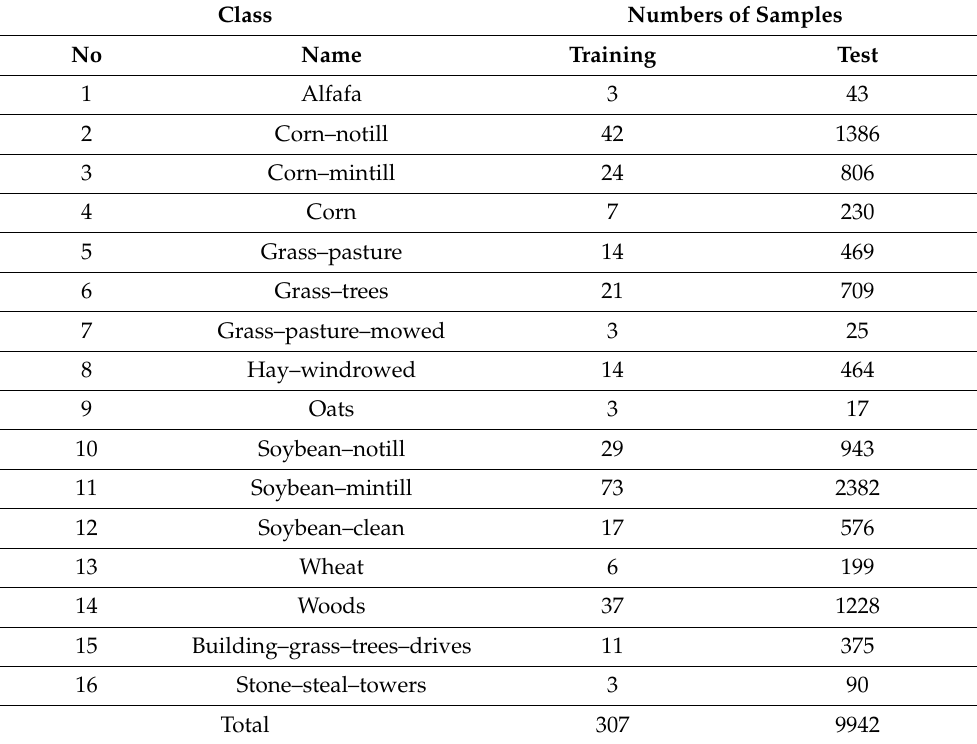
Table 2. Number of training and test samples in the IN data set.